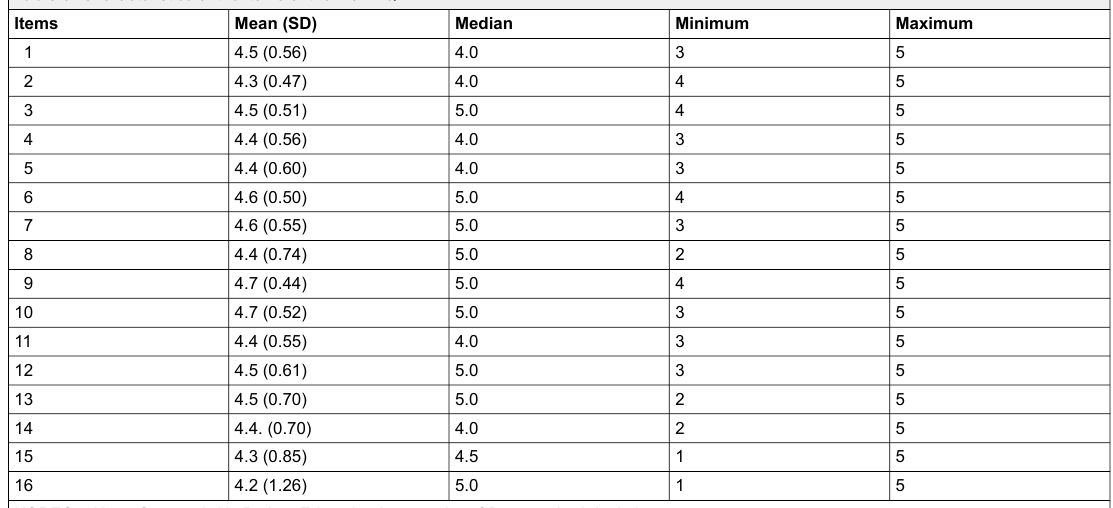
Table 3: Characteristics of the items of the KOPEQ.